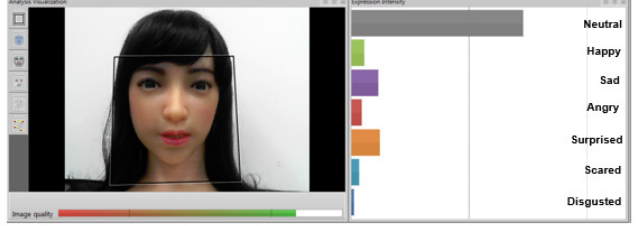
Figure 6. Results of EveR facial expression recognition using FaceReader.